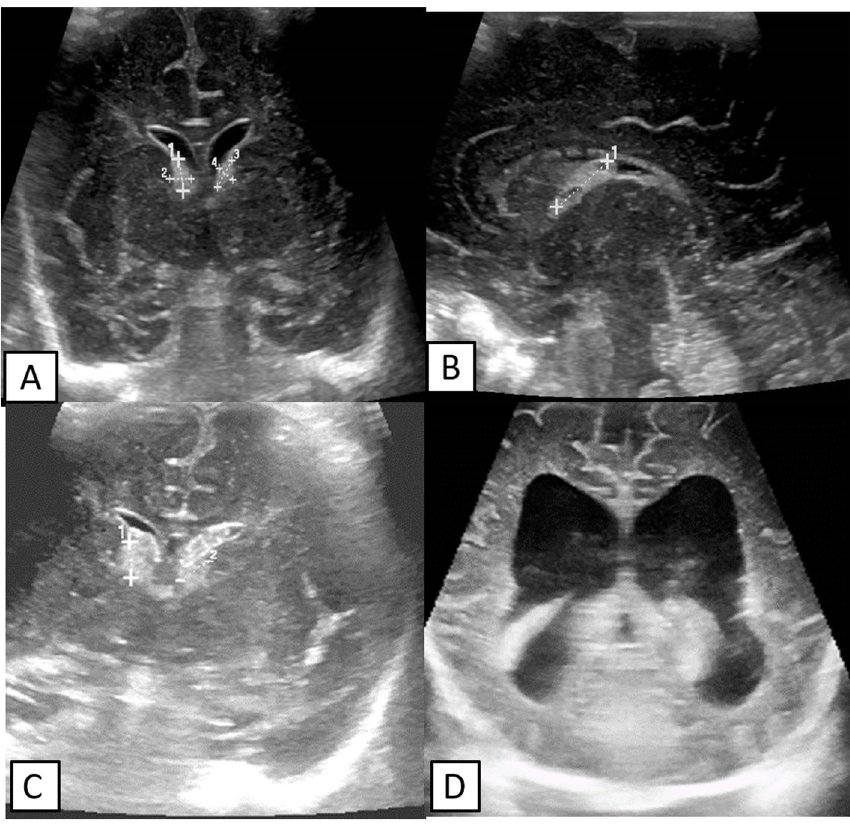
Fig. 1 CUS images in four neonates showing bilateral GMH without IVH with no ventriculomegaly ( A ), left GMH in para-sagittal scan ( B ), bilateral GMH with an intra-ventricular extension on the left side ( C ), and post-hemorrhagic ventricular dilatation ( D )